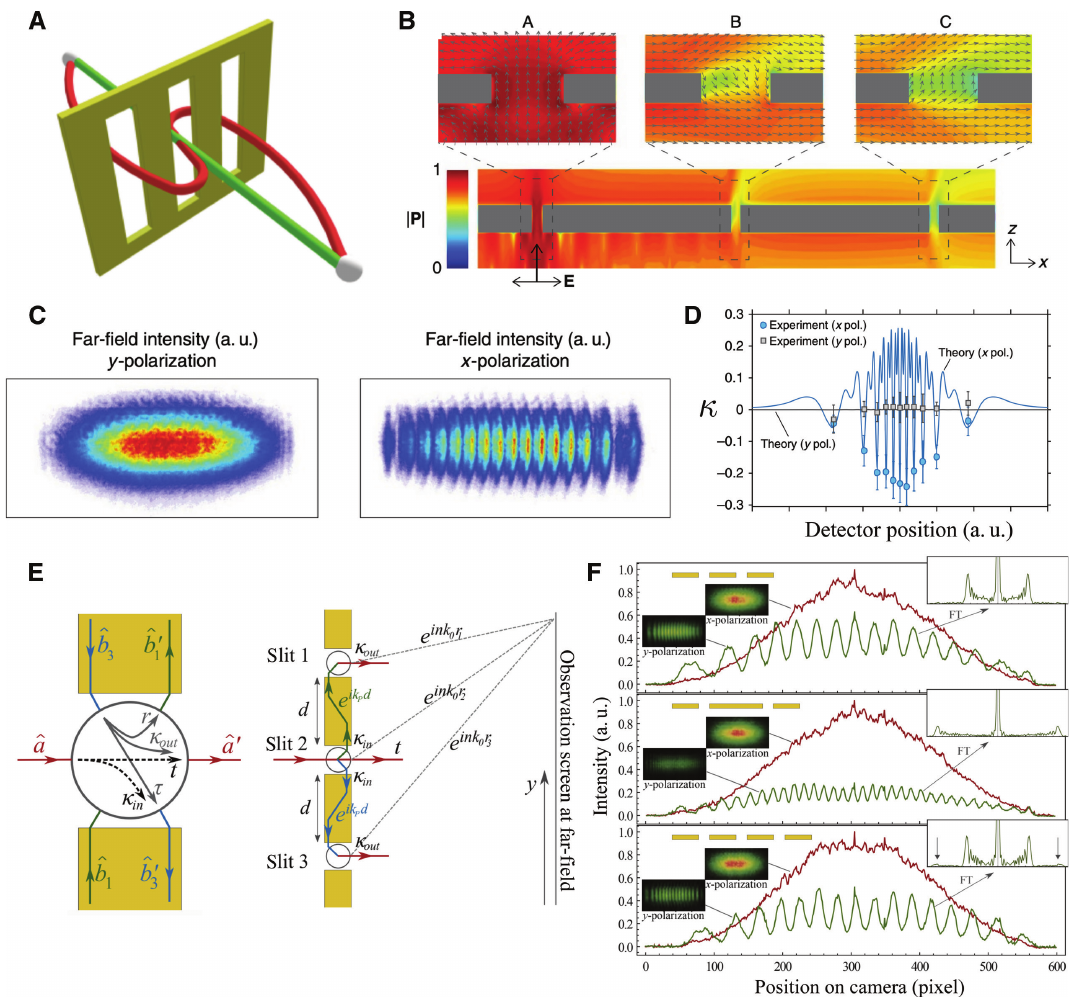
Figure 12: Hybrid photonic-plasmonic multiport devices. (A) Looped and straight trajectories of photons in a three-slit interferometer. (B) Magnitude of the Poynting vector P in the vicinity of metallic slits for a case in which a single slit is illuminated with photons polarized along the x -direction. (C) Measured far-field distributions of single photons for the case studied in (B). The appearance of fringes is attributed to interference among photons traveling in straight and looped trajectories. (D) Parameter κ , which quantifies the complexity of the process. (A–D) Reproduced from Ref. [32]. (E) Photon- plasmon scattering processes in a plasmonic tritter and the schematic diagram of the triple-slit structure when each slit is a tritter. (F) Far-field interference patterns from the three different slit structures. Only the photons with y polarization excite SPPs (green), whereas no interference occurs for x polarization (red). (E and F) Reproduced from Ref.